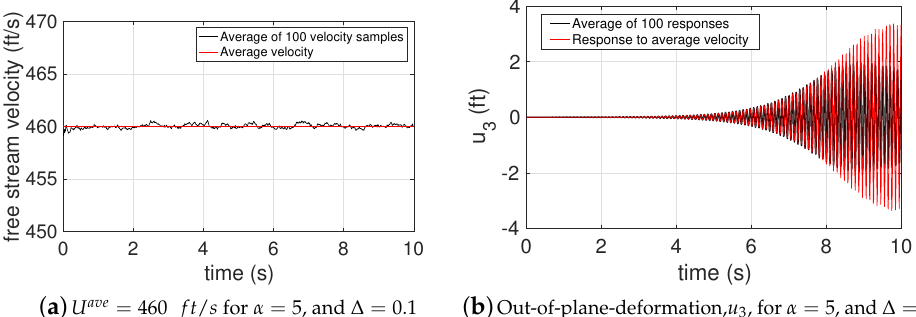
Figure 22. Illustration of law of large numbers with 100 samples for an unstable average velocity. A trigonometric correlation function controls the phase of samples. Figure 23a,c show samples of free-stream velocity for U ave = 430 ft / s with correlation function r xx = Cos ( ω 0 τ ) with ω 0 = 1 and ω 0 = 2 π , respectively. As ω 0 increases, the frequency of U increases. Figure 23b,d show the out-of-plane tip deformation for ω 0 = 1 and ω 0 = 2 π , respectively. Since the free-stream velocity samples remain in the stable region, all results are stable. Figure 24a,c show samples of free-stream velocity for U ave = 450 f t / s with correlation function r xx = Cos ( ω 0 τ ) with ω 0 = 1 and ω 0 = 2 π , respectively. As ω 0 increases, the frequency of U increases. Figure 24b,d show the out-of-plane tip deformation for ω 0 = 1 and ω 0 = 2 π , respectively. In both cases, the average velocity is in the unstable region. However, Figure 24d shows an unstable behavior while Figure 24b shows a beating behavior. Figure 25a,c show samples of free-stream velocity for U ave = 460 f t / s with correlation function r xx = Cos ( ω 0 τ ) with ω 0 = 1 and ω 0 = 2 π , respectively. As ω 0 increases, the frequency of U increases. Figure 25b,d show the out-of-plane tip deformation for ω 0 = 1 and ω 0 = 2 π , respectively. In both cases, the average velocity is in the unstable region, and the oscillations are unstable with a beating